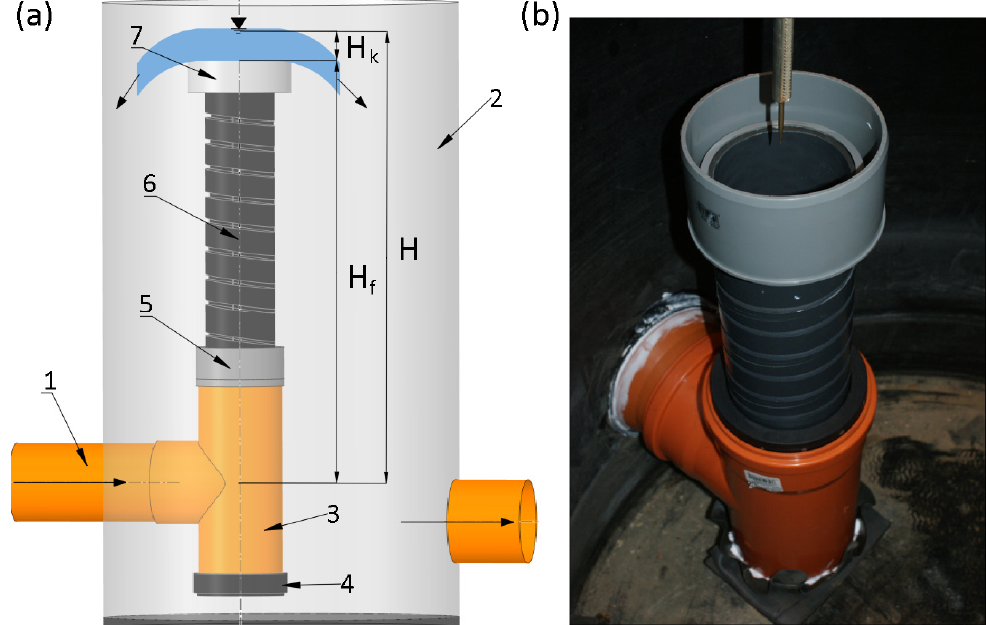
Figure 2. Measurement scheme ( a ) and photo ( b ) of the funnel regulator: 1—drain; 2—drainage well; 3—tee; 4—drain plug; 5—stabilising ring (base); 6—threaded stem pipe; 7—funnel overflow; H f —height of the funnel overflow edge position above the drain axis; H k —water depth in the shaft pipe axis above the edge of the funnel overflow; H—height of the water level in the shaft pipe in relation to the drain